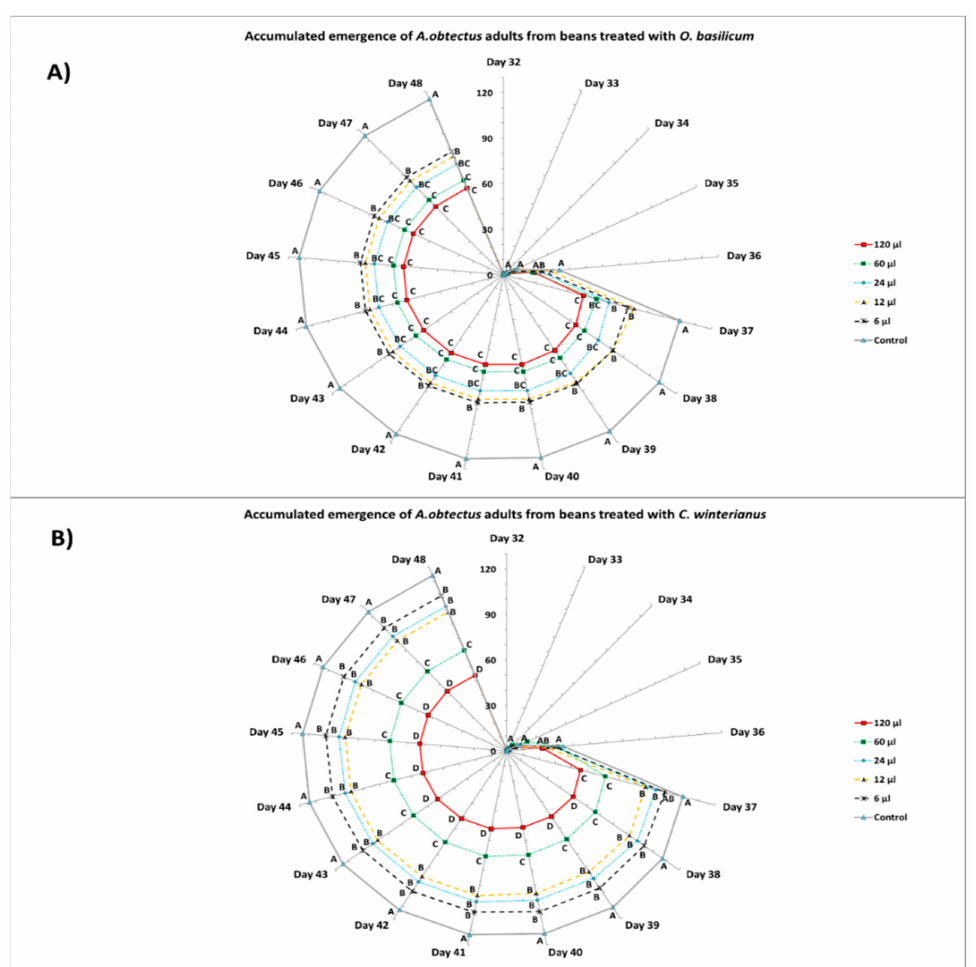
Figure 3. Accumulated emergence (mean ± SE) of A. obtectus adults in 0.33 L / glass jar from beans treated with di ff erent doses of O. basilicum ( A ) and C. winterianus ( B ) essential oils. Di ff erent capital letters indicate significant di ff erences among doses and control for the same day; LSD test at